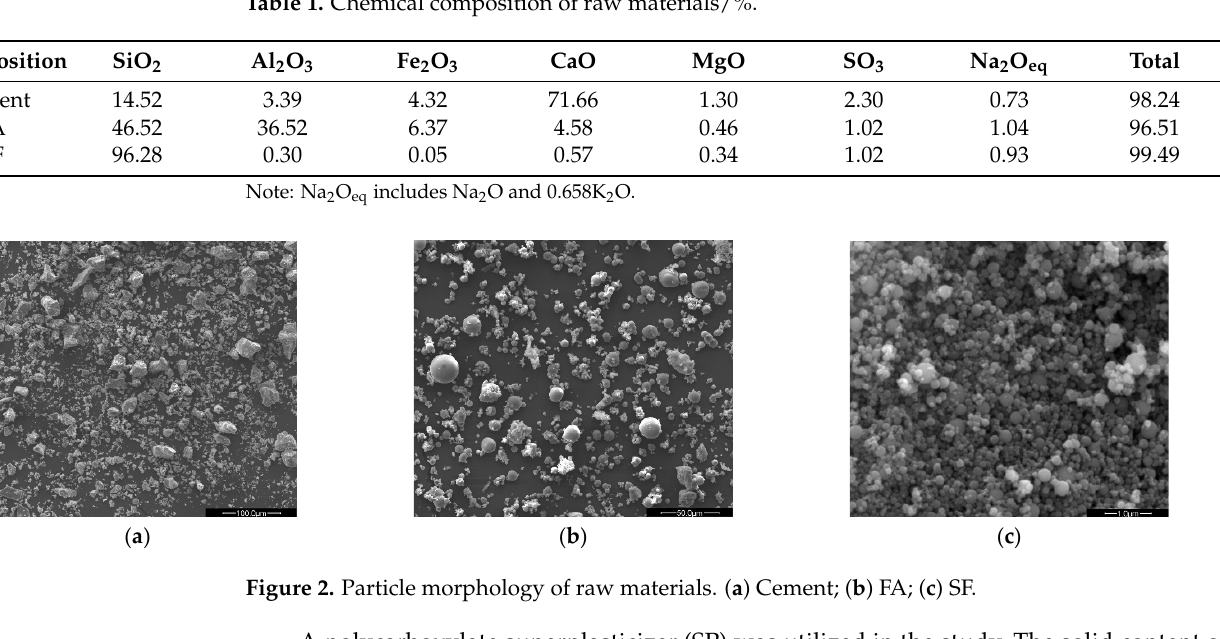
Table 1. Chemical composition of raw materials/%.